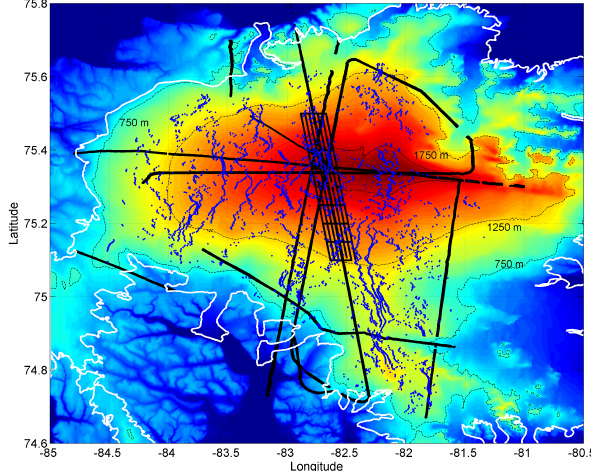
Figure 3. Digital elevation model of Devon Ice cap showing the positions of the spring 2011 reference surface elevations (in black) and the CS2 elevations (in blue) acquired between 1 January and the end of May 2011. The rectangular grid over the ice cap sum- mit was collected from ground-based kinematic GPS surveys while the remaining transects were collected by ESA and NASA airborne missions. The white line indicates the approximate outer limit of glacial